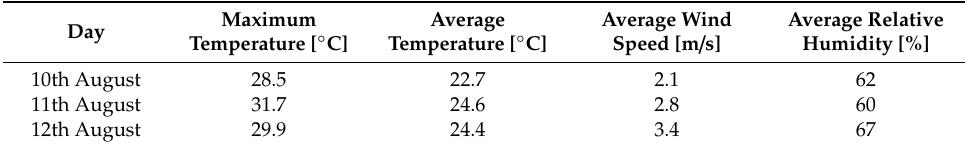
Table 5. Overview of the weather statistics for the study period in August, 2018. (derived from the same TRY file).